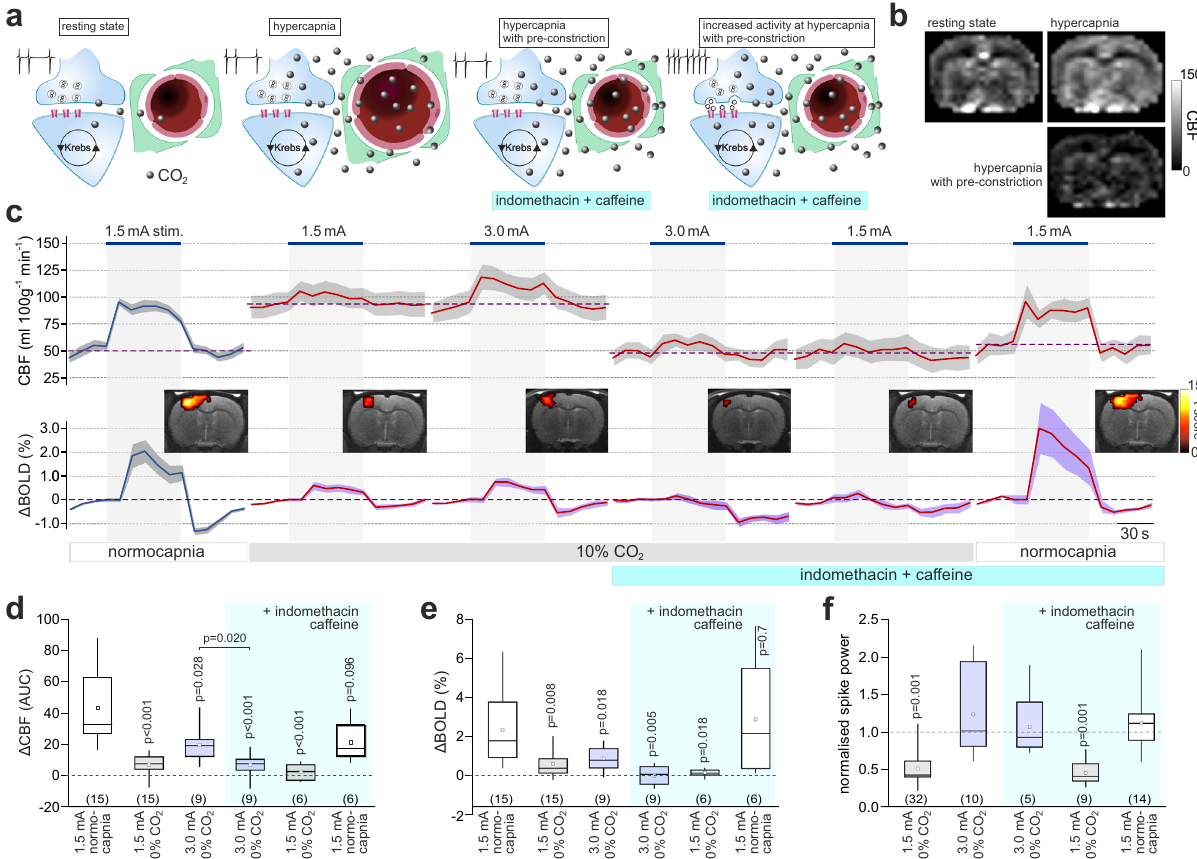
Fig. 3 Exogenous CO 2 prevents the development of the neurovascular response in the somatosensory cortex independently of changes in basal CBF. a Schematic depiction of the neurovascular unit illustrating the experimental approach used to control for the effect of systemic hypercapnia on basal CBF. Extra CO 2 generated during enhanced neuronal activity has no effect on local blood fl ow in the presence of surplus of exogenous CO 2 . However, under these conditions the cerebral vasculature is dilated and may lack the capacity to dilate further. To counteract the action of 10% inspired CO 2 on brain vasculature, the animals were given a combination of caffeine and indomethacin (both at 10 mg kg − 1 , i.v.) to reduce the CBF to the baseline level recorded at normocapnia. b Representative ASL images illustrating CBF at rest (normocapnia), in conditions of 10% inspired CO 2 , and after the systemic treatment with caffeine/indomethacin at 10% inspired CO 2 . c CBF and BOLD responses in the S1FL region induced by forepaw stimulation at baseline, in conditions of 10% inspired CO 2 , after the systemic administration of caffeine and indomethacin in conditions of 10% inspired CO 2 , and after the withdrawal of inspired CO 2 . To compensate for CO 2 -induced inhibition of the neuronal activity, the intensity of forepaw stimulation was increased two-fold from 1.5 to 3 mA when 10% inspired CO 2 was applied. Data are presented as mean values ± SEM (shaded areas denote error bands). Insets show representative activation maps illustrating mean BOLD signal changes in response to somatosensory stimulation. Color bar: t -score from statistical paramagnetic mapping mixed-effects analysis, p < 0.05 (uncorrected). d , e Summary data illustrating CBF and BOLD responses in the S1FL region induced by electrical forepaw stimulation at baseline, in conditions of 10% inspired CO 2 , evoked by 3 mA stimulus intensity in conditions of 10% inspired CO 2 , after the systemic administration of caffeine/indomethacin in conditions of 10% inspired CO 2 , and after the withdrawal of inspired CO 2 . P values, Kruskal – Wallis test followed by Dunn ’ s multiple comparison test. f Summary data illustrating the effect of each of the experimental conditions on the neuronal responses (expressed as spike power) in the S1FL region triggered by electrical forepaw stimulation. Integrated spike activity was normalized and presented relative to the responses recorded at baseline. P values, one-way ANOVA followed by Tukey ’ s multiple comparison test. In the box-and-whisker plots the central dot indicates the mean, the central line indicates the median, the box limits indicate the upper and lower quartiles, and the whiskers show the minimum – maximum range of the data. Numbers in parentheses indicate sample sizes (number of animals per experimental group). Source data are provided as a Source Data fi